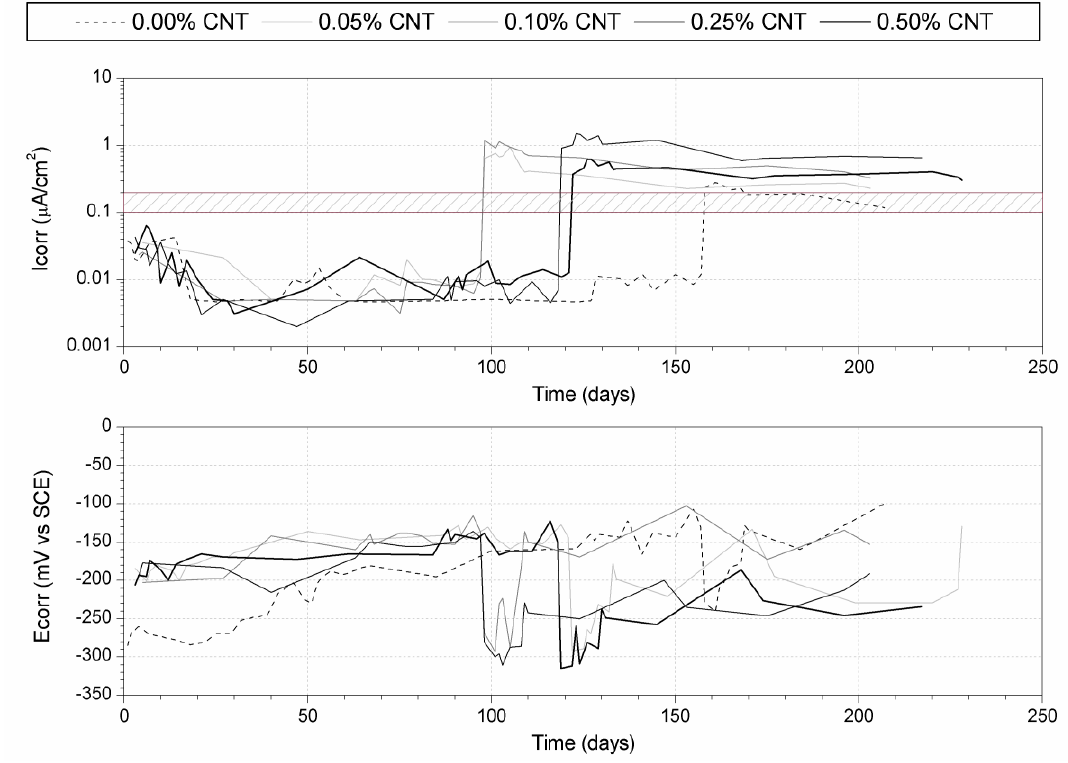
Figure 3. Evolution of corrosion potential ( E embedded in CNT cement pastes exposed to accelerated